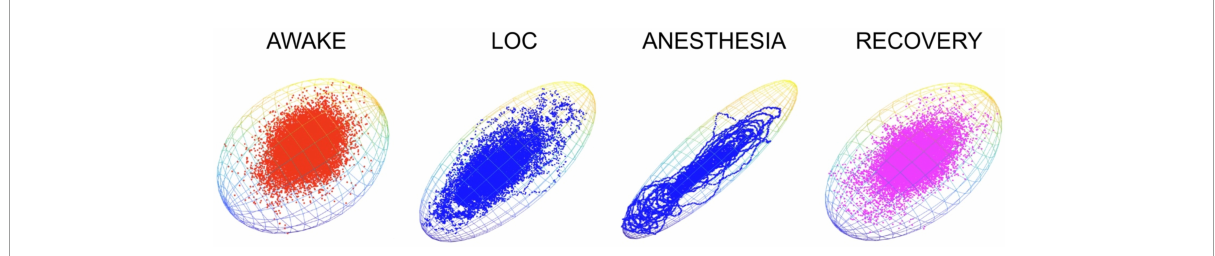
FIGURE3 Chaotic attractors provide a sensitive measure of levels of consciousness in subjects exposed to an anesthetic. EEG signals were recorded from frontal cortex and processed as previously described (Eagleman et al., 2018b). Attractor plots produce spherical clouds in awake subjects. Loss of consciousness (LOC) is associated with a flattening of the attractor cloud. A further flattening is seen at surgical planes of anesthesia, with a return to a more spherical shape upon recovery, following removal of the anesthetic. Grids indicate best fit boundaries for each 3-D matrix. Unpublished data from Eagleman and